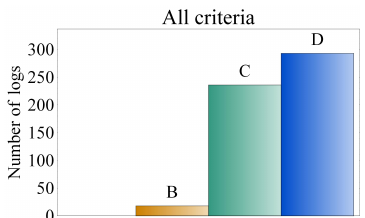
Figure 3. Results of visual grading with all characteristics (1–17).